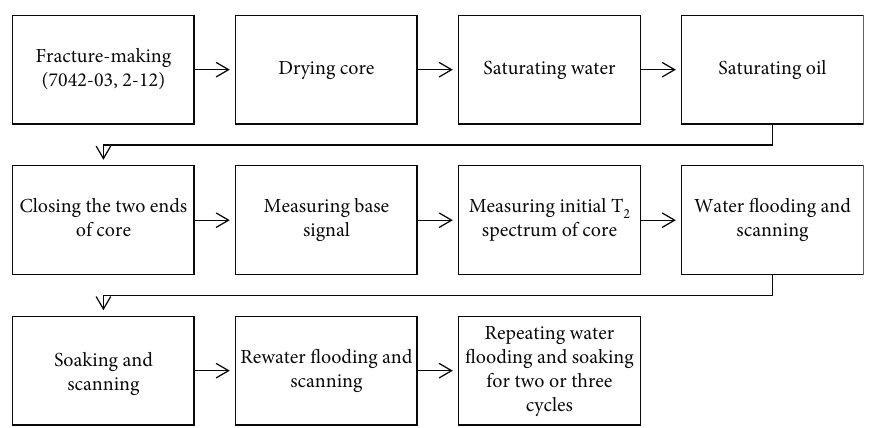
Figure 4: A work fl ow